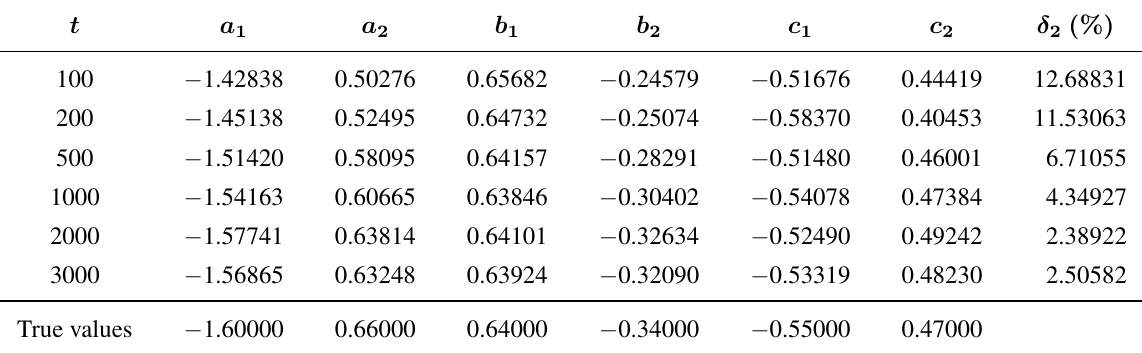
Table 3. The recursive generalized least squares (RGLS) estimates and